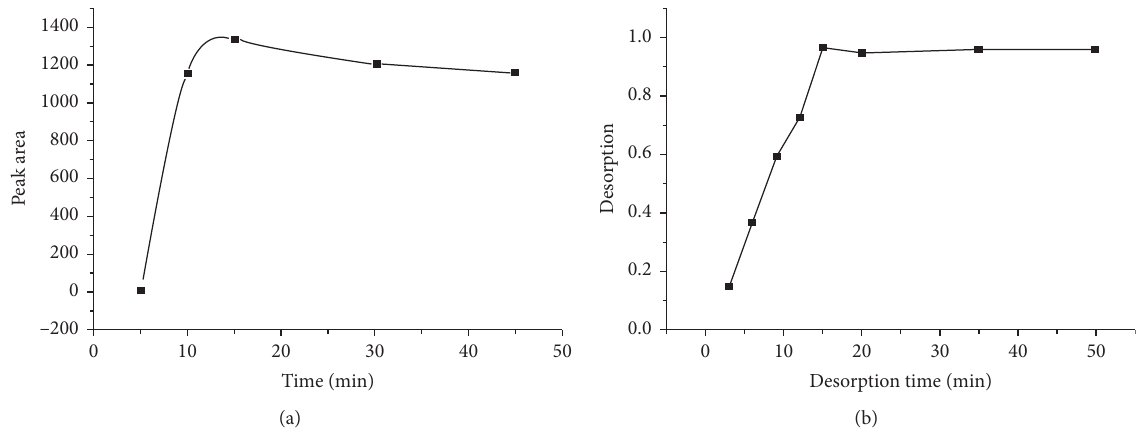
Figure 5: (a) Effect of adsorption time; (b) effect of desorption